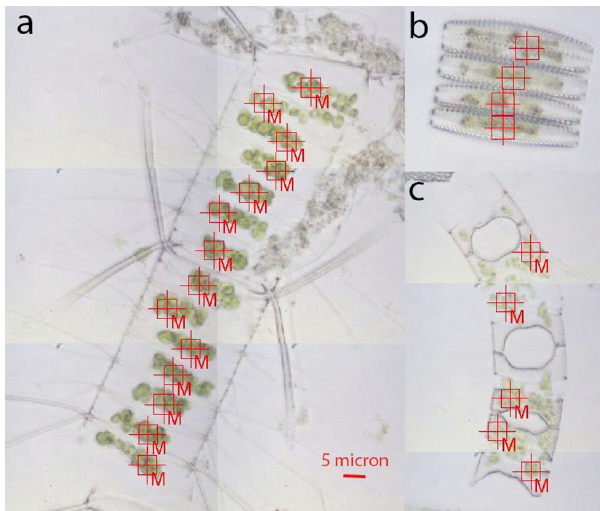
Figure 1. Visible images of Chaetoceros spp. (a) , F. kerguelensis (b) and E. antarctica (c) cells showing the infrared measurement po- sitions (indicated by cross-hairs). The red square around the cross- hairs indicates that the aperture size on the infrared microscope was set to 5 ×